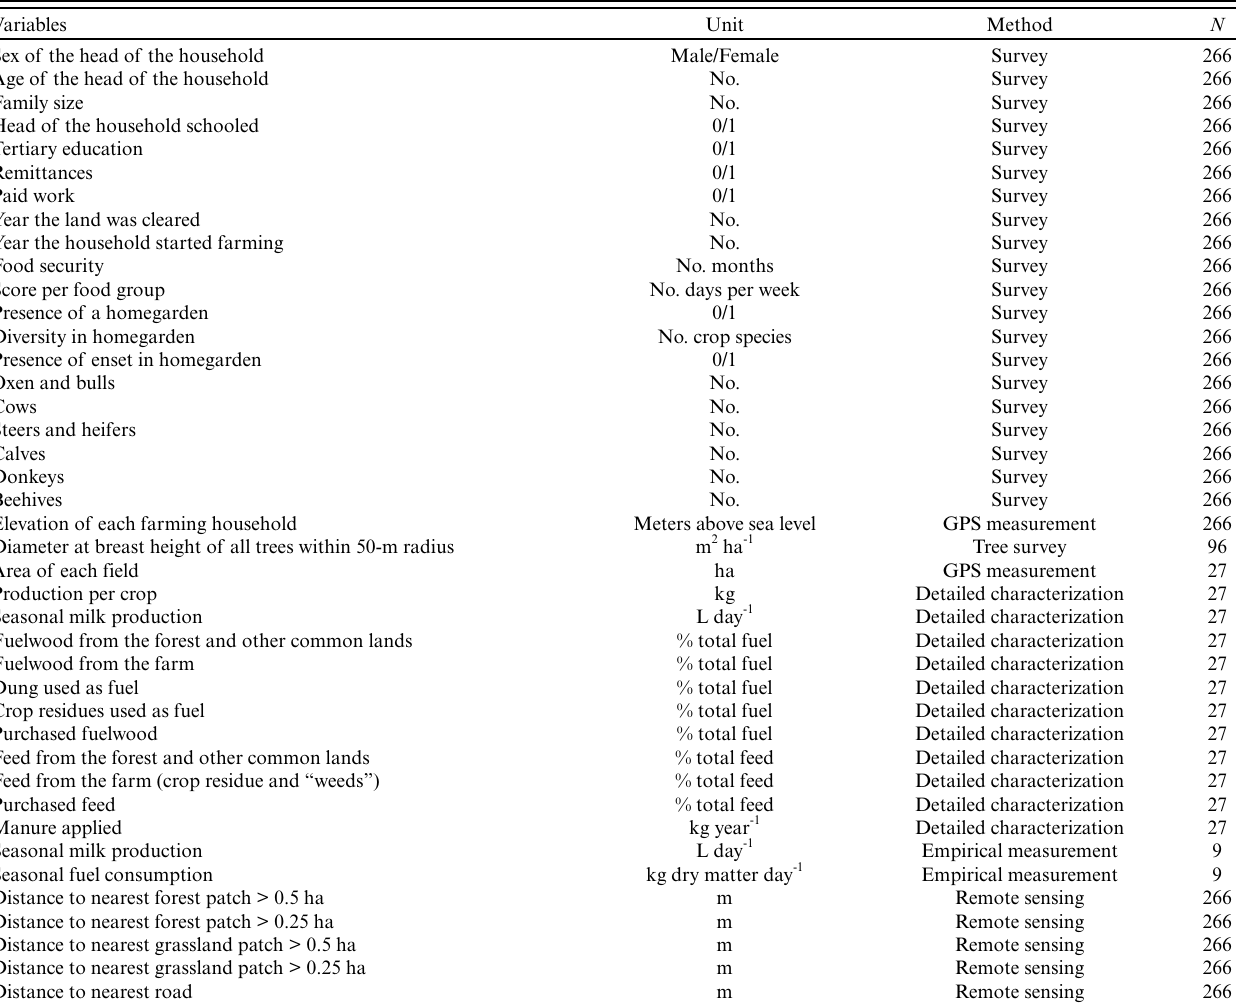
Table 1 . Summary of the main variables assessed, their units, the methods of assessment, and the size of the samples ( N ).